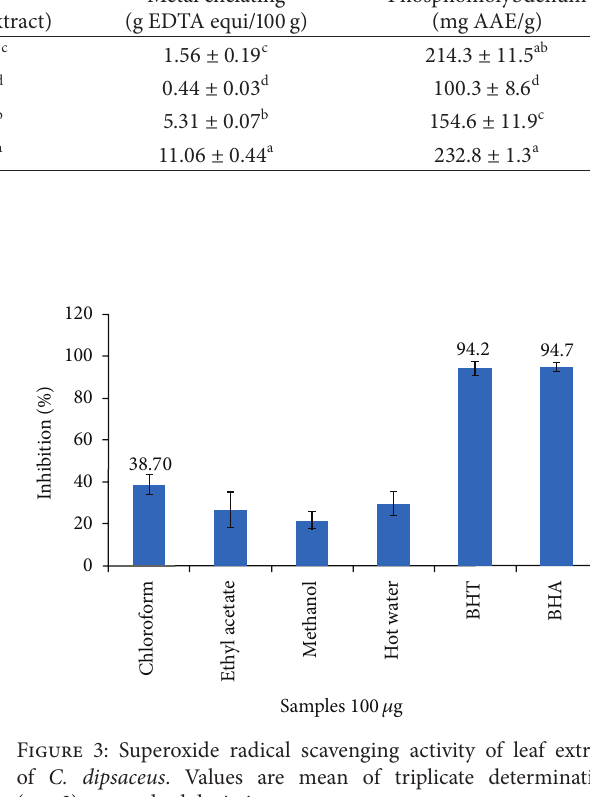
Table 4: ABTS, FRAP, metal chelating, and phosphomolybdenum radical scavenging activity of C. dipsaceus leaf. Sample extracts